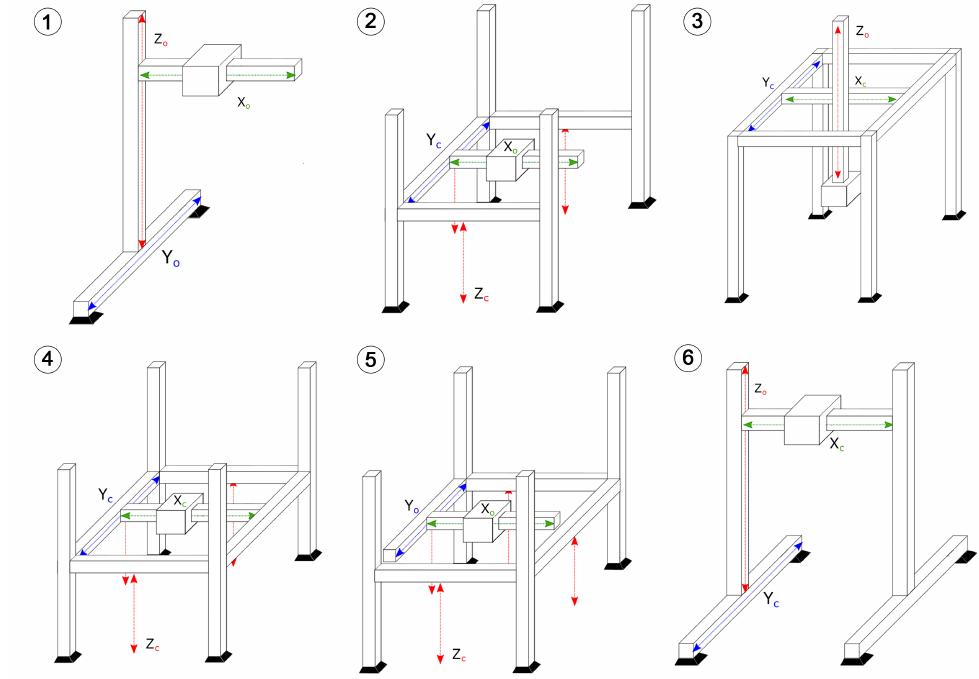
Figure A5. Fixed axes X B , Y B , Z B and actuated axes X H , Y H , Z H . Existing designs are 3 and